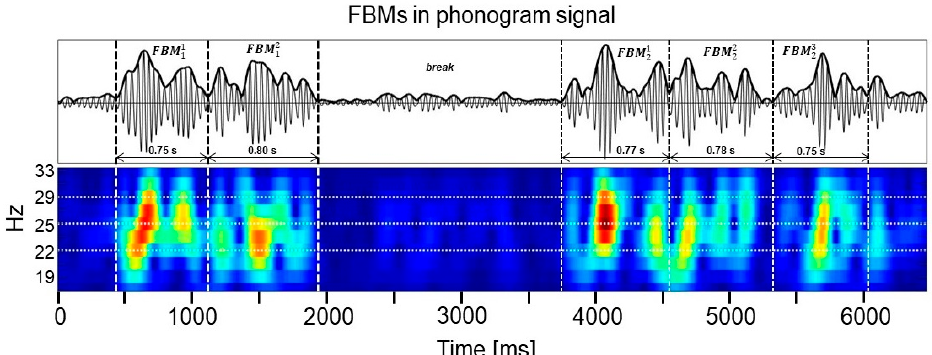
Figure 6. There is a time duration classified as break between two episode groups, displayed by wavelet transformation.